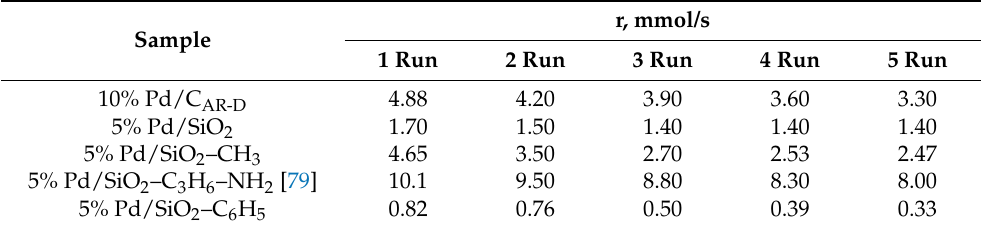
Table 1. Indicators of the reaction rate for various catalysts.